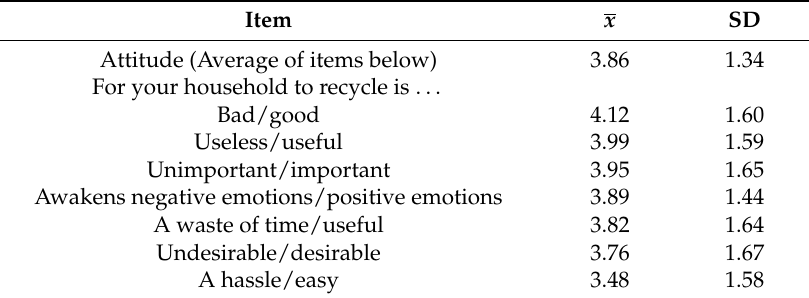
Table 4. Descriptive statistics for the attitude of respondents towards recycling.